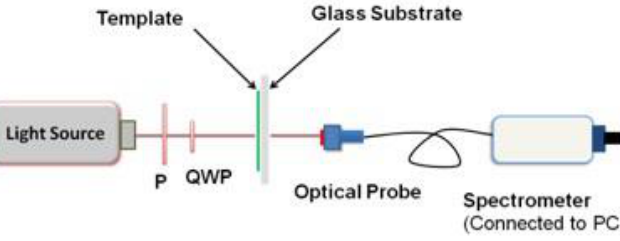
Figure 2. Experimental system for the transmission spectrum of blue phase liquid crystal.